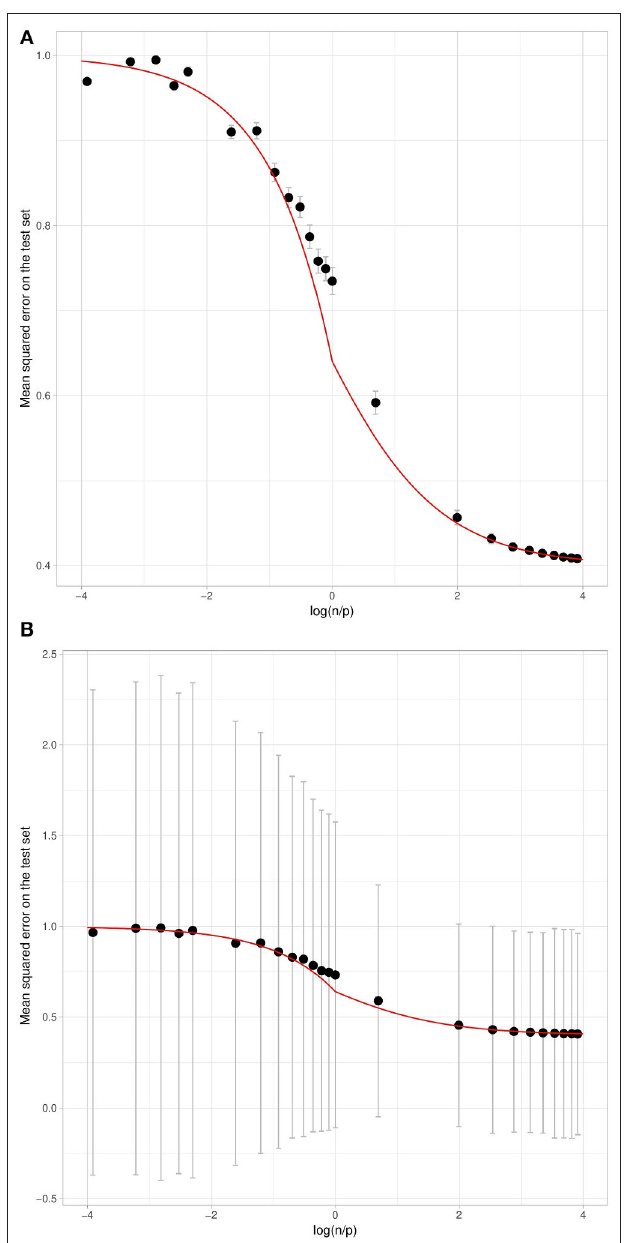
FIGURE 6 | Mean Squared Error of the prediction on the test set with respect to log( n ), using simulated data with h 2 = 0.6. The curves correspond to the p theoretical link for h 2 = 0.6. The black points correspond to the mean expectation for each value of log( n ) over 300 repetitions. The error bars in p (A,B) correspond respectively to one standard deviation of the test set error obtained using two different aggregation strategies. On the left (A) , we consider an aggregation strategy where each of the 300 training sets results in a mean test set error, whereas on the right (B) each individual in the test set results in an error averaged over all training sets.